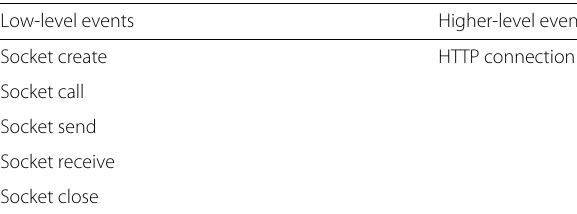
Table 4 Abstracting example